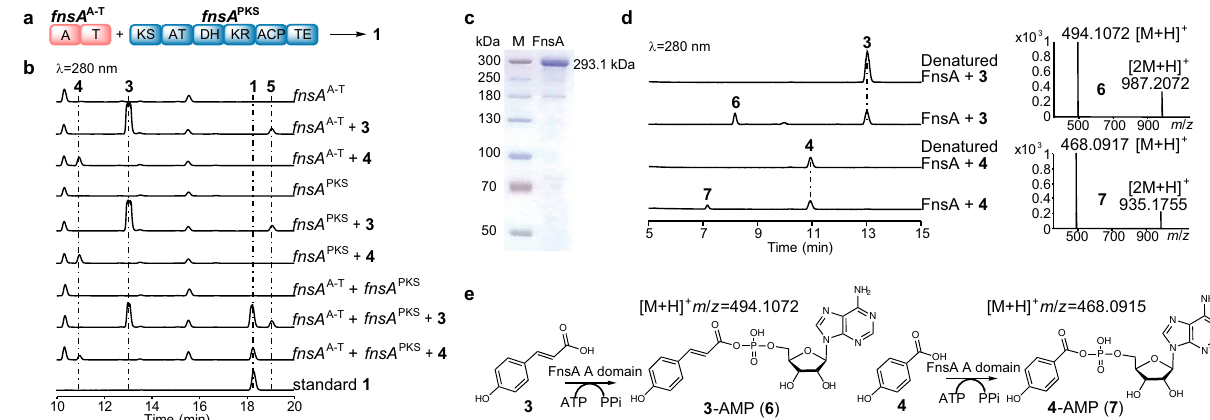
d HPLC analysis of the enzyme reactions of FnsA with 3 or 4 . EICs at m/z 494.1072 and 468.0917 refer to [M+H] + ions of products 3 -AMP ( 6 ) and 4 -AMP ( 7 ), respec- tively. e Illustration of the reactions catalysed by the FnsA A domain. Each experi- ment ( c ) was repeated twice independently with similar results. Source data are provided as a Source Data fi